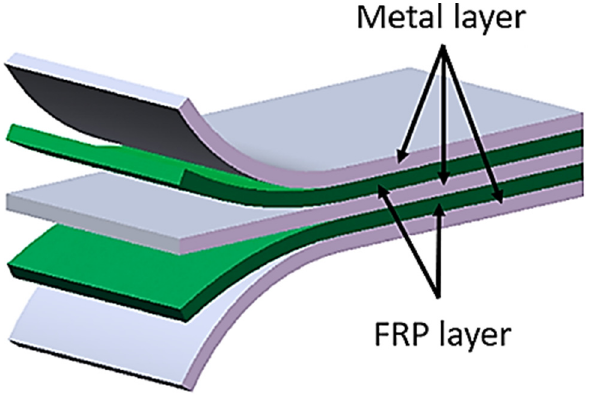
Figure 1. Fiber metal laminate configuration (adapted from [7]).